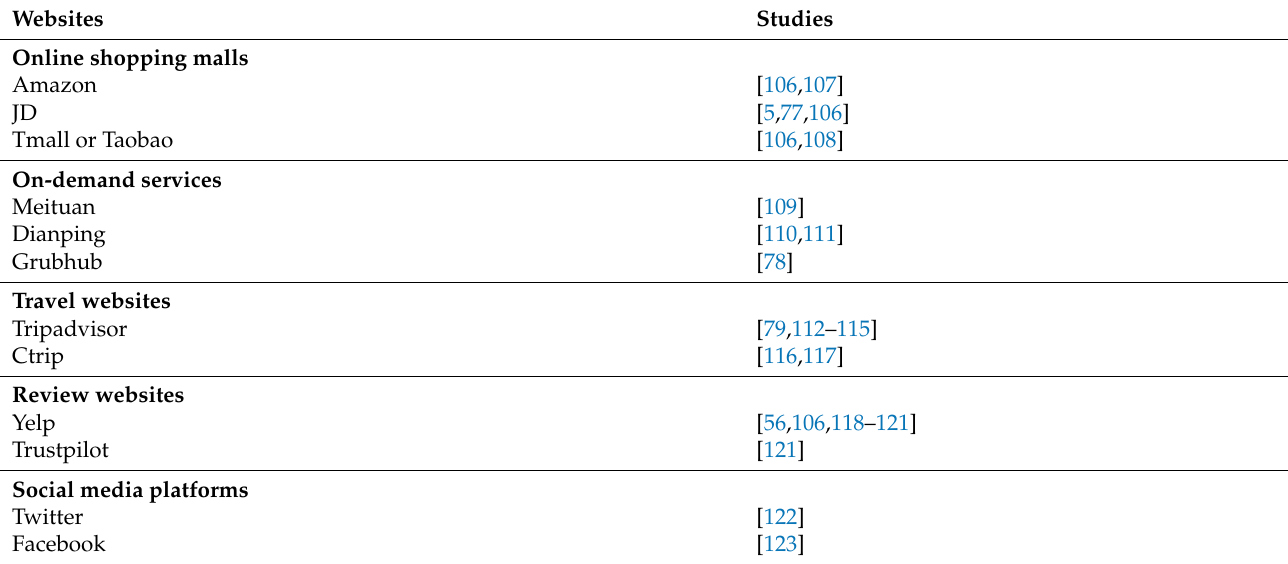
Table 4. Sources of UGC in practice.